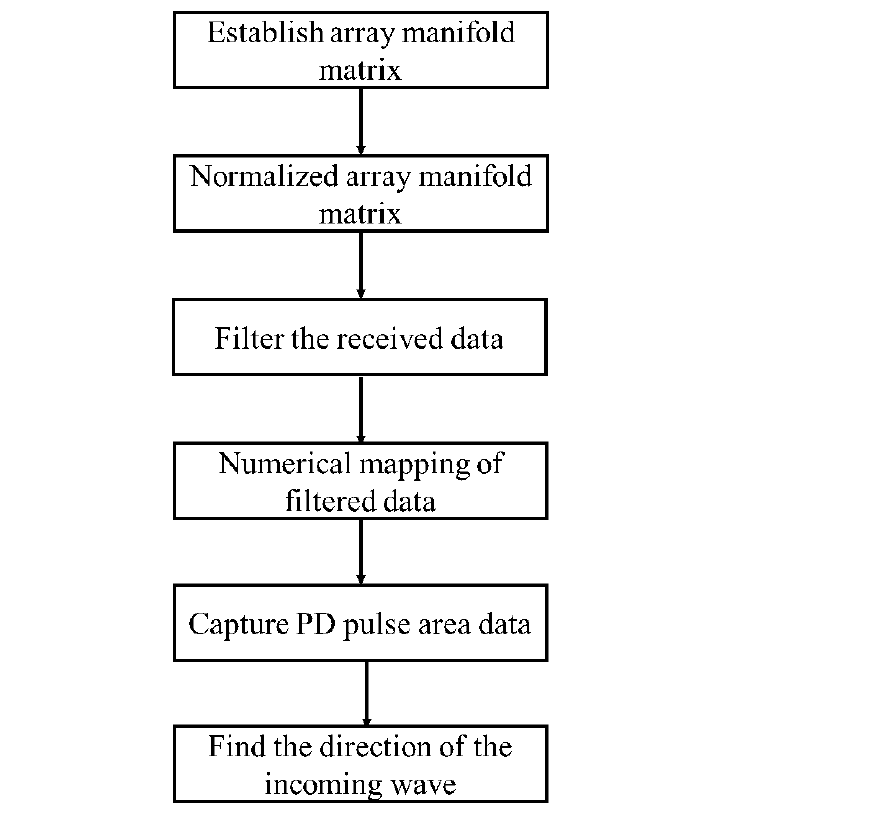
Figure 13. Flowchart of the Dir-MUSIC algorithm.